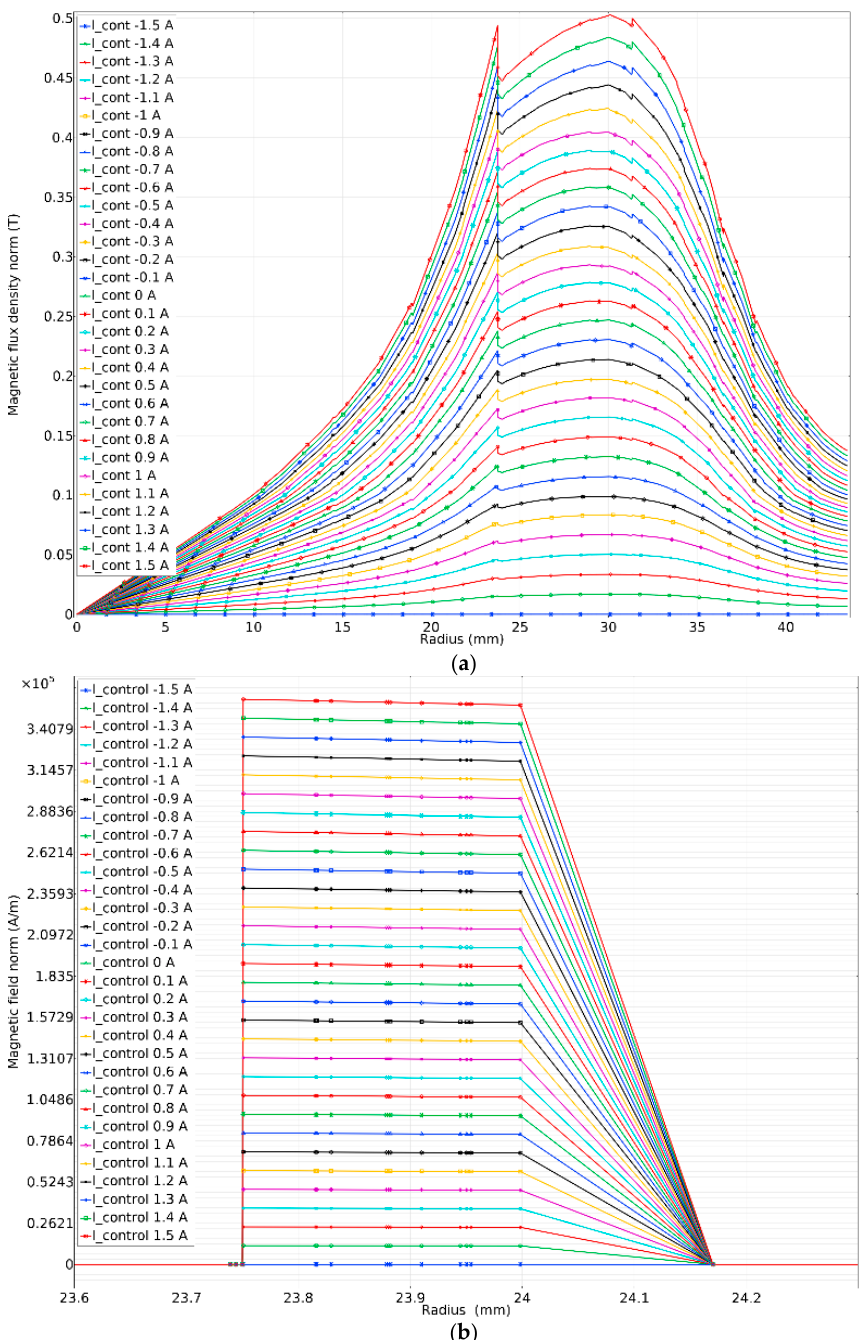
Figure 11. Distribution of magnetic flux density of ( a ) the magnetic field and ( b ) along the radial bearing for the control current.